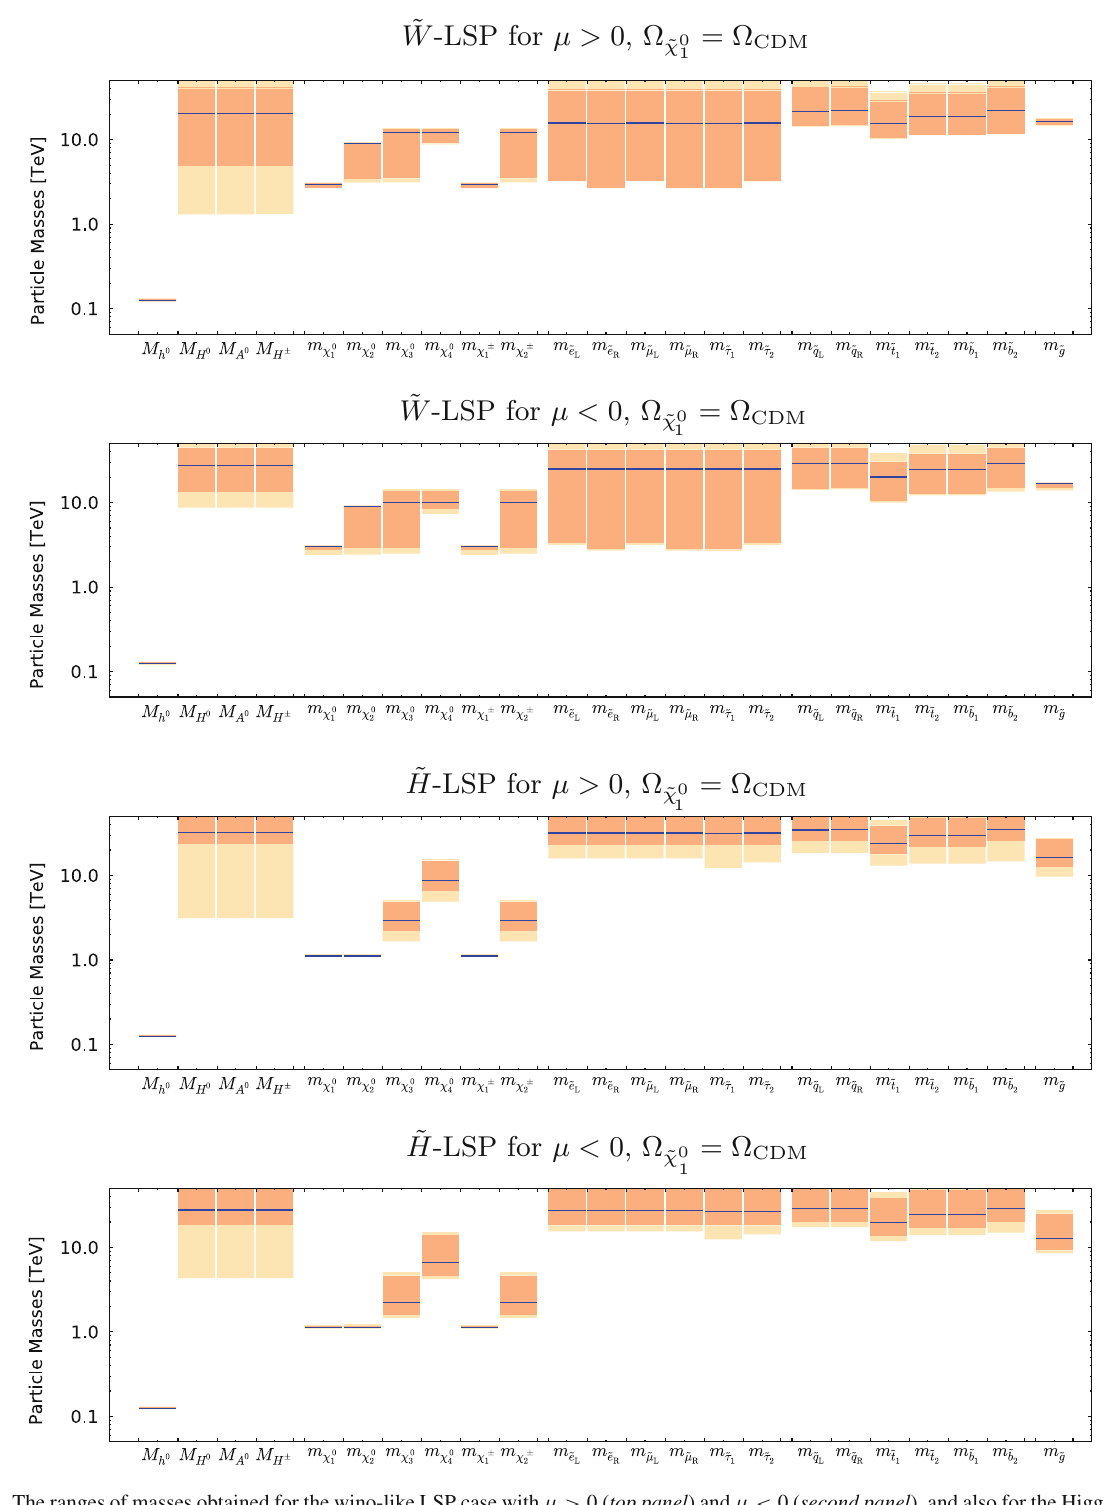
Fig. 9 The ranges of masses obtained for the wino-like LSP case with μ > 0 ( top panel ) and μ < 0 ( second panel ), and also for the Higgsino-like LSP case for μ > 0 ( third panel ) and μ < 0 ( bottom panel ), assuming that the LSP makes the dominant contribution to the cold dark matter